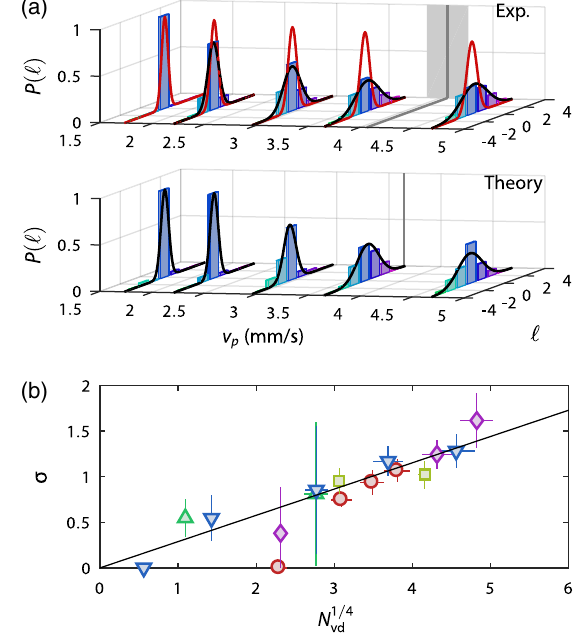
FIG. 5. (a) Measured winding number distributions for a ¼ 1 . 4 ð 1 Þ (histograms) with Gaussian fits (black curves) for the experiment (top) and simulations (bottom). The gray vertical line and bar show, for comparison, the speed of sound and its uncertainty. The red Gaussians show the expected distribution from the horizon model (see text). (b) Width of the winding number distribution σ vs the number of vortex dipoles predicted by the soliton model, N . The red circles denote a ¼ 1 . 31 ð 9 Þ vd